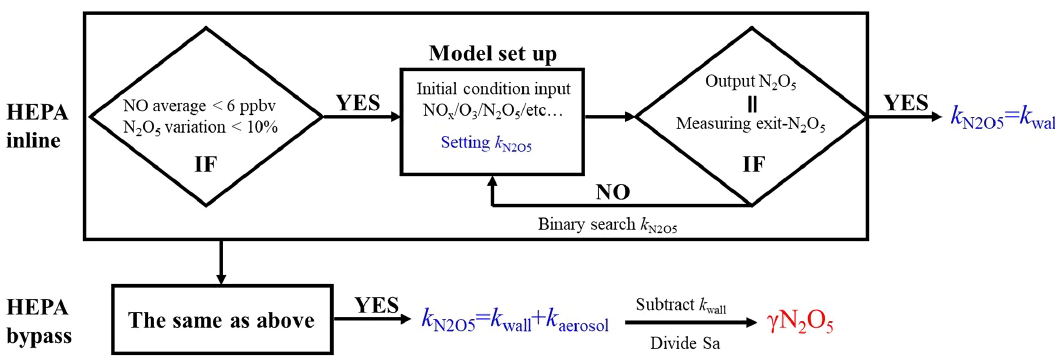
Figure 5. Flow diagram of γ( N 2 O 5 ) derivation through the box model